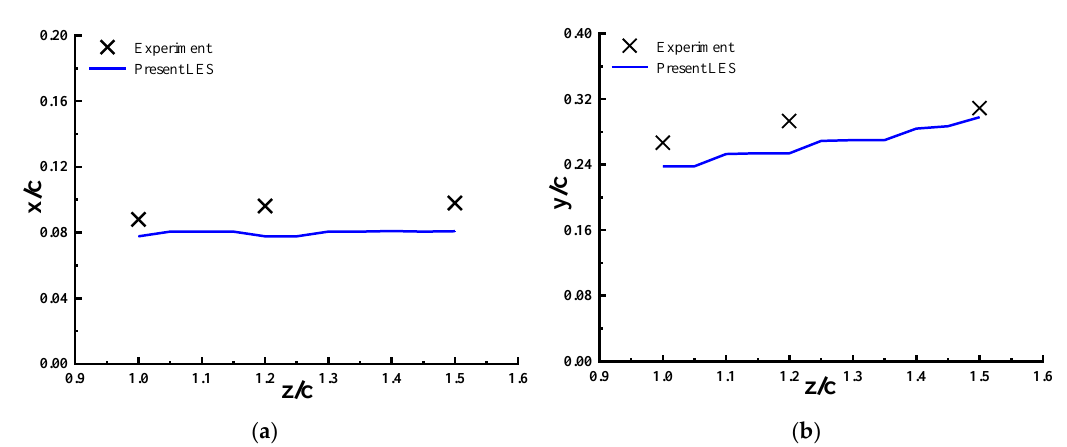
Figure 6. Comparison of trajectories of TLV: ( a ) spanwise, and ( b ) pitchwise.